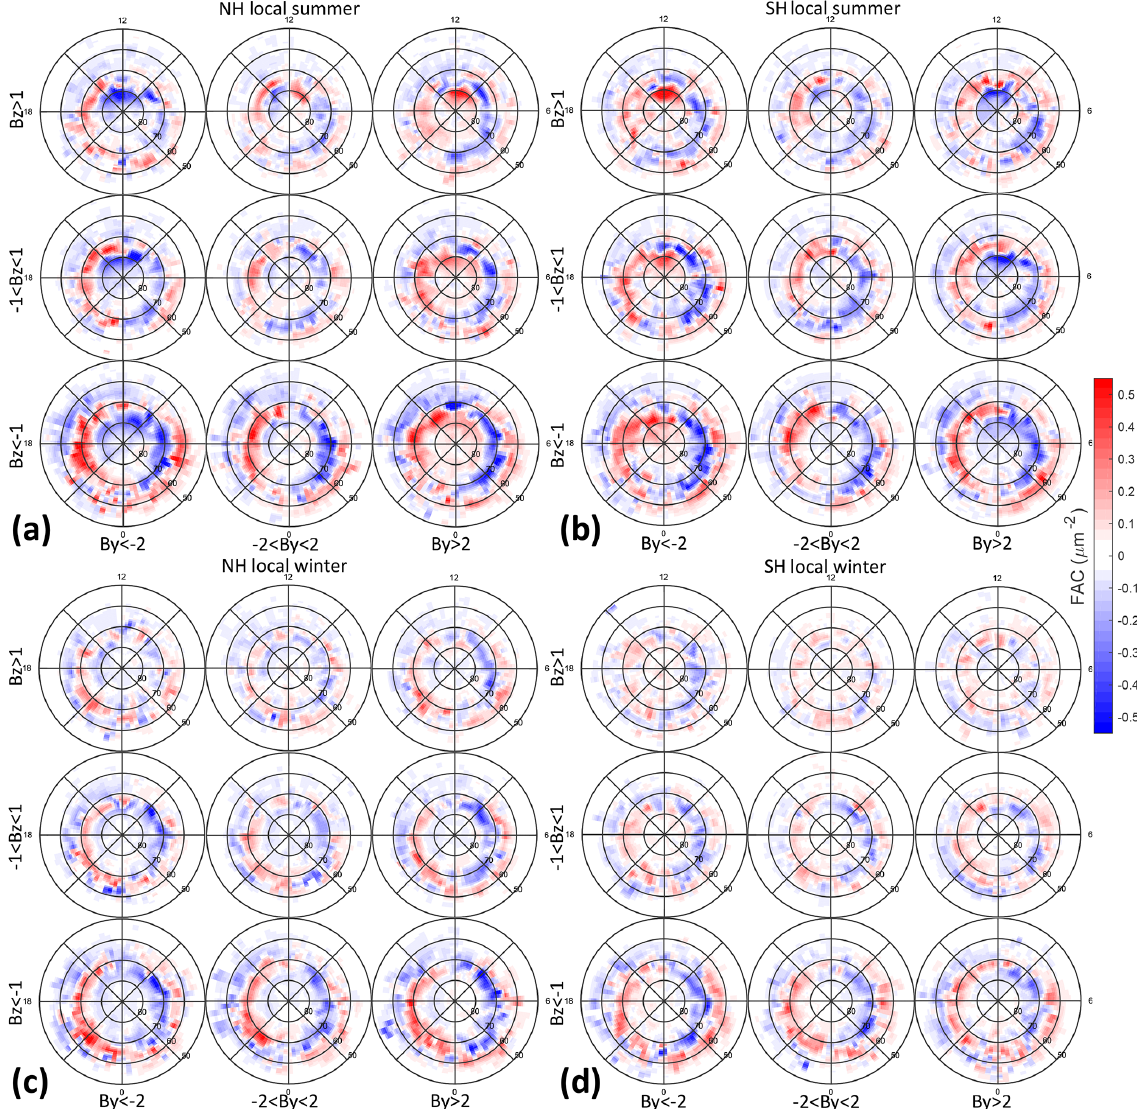
Figure 3. Maps of average FAC distribution in the Northern Hemisphere (a, c) and Southern Hemisphere (b, d) for local summer (a, b) and local winter (c, d) . The FAC distribution is shown in the frame of magnetic latitude (MLAT) versus magnetic local time (MLT) for B z > 1, − 1 <B z < 1 and B z < − 1 conditions in rows from top to bottom in each panel. IMF B y ranges change from B y < − 2, − 2 <B y < 2 to B y > 2 from left to right columns. The blue (red) contours indicate downward (upward)